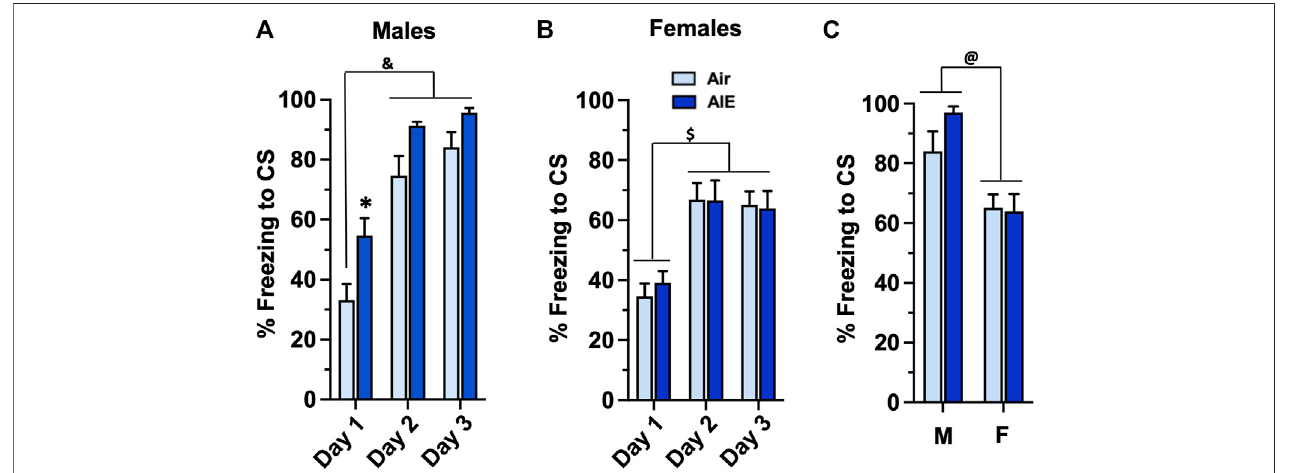
FIGURE 2 | AIE exposure results in sex-speci fi c increases in the acquisition of conditioned fear in adulthood. (A) Adult male rats that had undergone adolescent intermittent ethanol (AIE) exposure exhibited a signi fi cant increase in freezing during tone-shock pairings compared to male Air control rats. (B) In contrast, adult female rats that had undergone AIE exposure did not exhibit any differences in freezing during the tone-shock pairings compared to thefemale Aircontrol rats. (C) Comparison ofpercentfreezingonConditioningDay3revealedthatfemaleratsexhibitedsigni fi cantlylowerlevelsoffreezingcomparedtomalerats. * ,signi fi cantdifferencefrom respective Day 1Air control, ( p =0.0295); &, signi fi cantdifference of Day 1and 2 groups compared toDay 1Air control (all p values < 0.0001); $, signi fi cant difference of Day 1 groups compared to Day 2 and 3 groups (all p values < 0.01); @, signi fi cant group difference of male compared to female groups ( p = 0.0001); n = 14/group for males, 16/group for